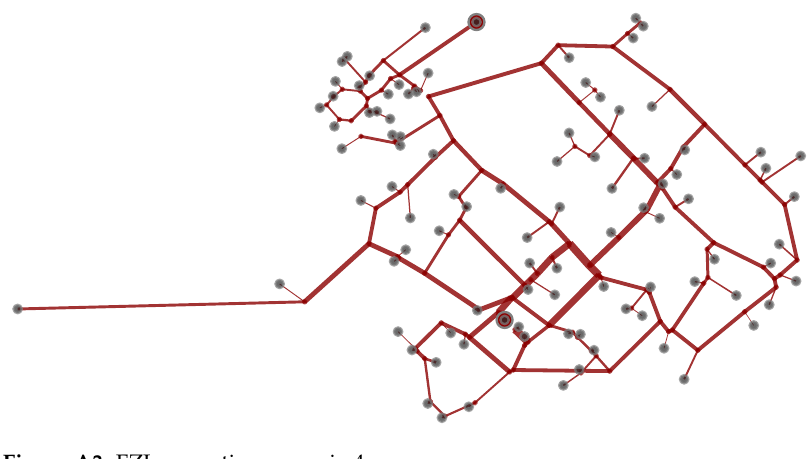
Figure A3. FZJ separation scenario 4.